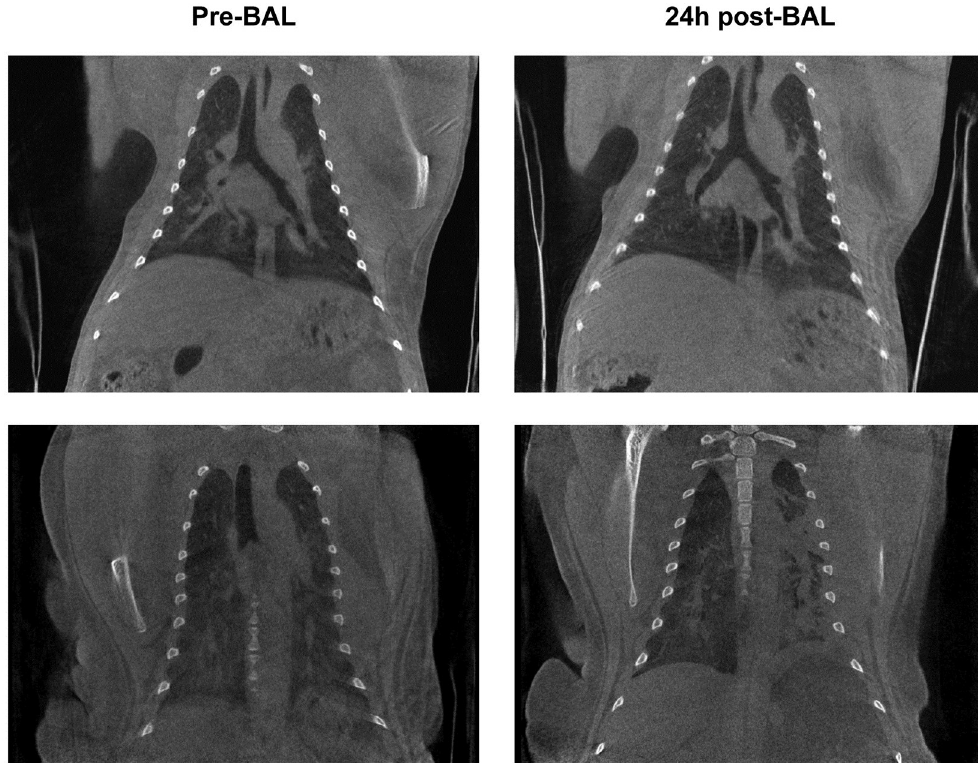
Fig 4. CTs of two infected animals. Upper row RM2; bottom row RM8. Pre-BAL on the left side, and 24 hours post-BAL on the right.